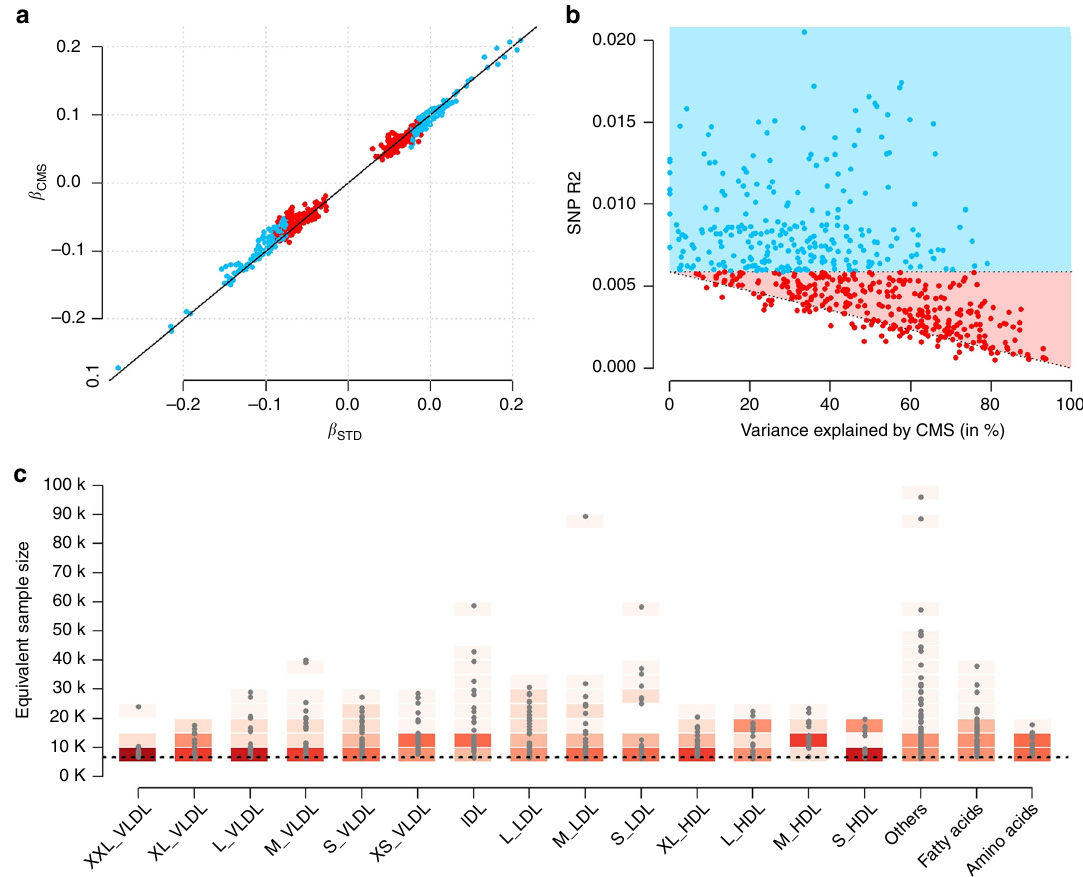
Fig. 2 Overview of CMS results. Characterization of results from the CMS adjusted analysis among the 588 identi fi ed region-metabolite associations. For all panels, we used the most associated SNP per region. a The regression coef fi cient for each SNP estimated using standard linear regression ( β STD ) and after adjustment for the covariates selected by CMS ( β CMS ). Associations signi fi cant at 1.28×10 − 9 with the standard test are indicated in blue, those only signi fi cant with CMS are indicated in red. b The outcome variance explained by the SNPs as a function of the variance explained by covariates selected by CMS for the corresponding associations. The blue and red areas correspond to the detectable SNP effect size for simple regression given the available sample size, and after explaining the residual outcome variance, respectively. c The gain in power achieved by CMS across the species analyzed, expressed as equivalent increase in sample size. The dash black line corresponds to the baseline sample size of 6623 individuals. The gradient of reds indicates the